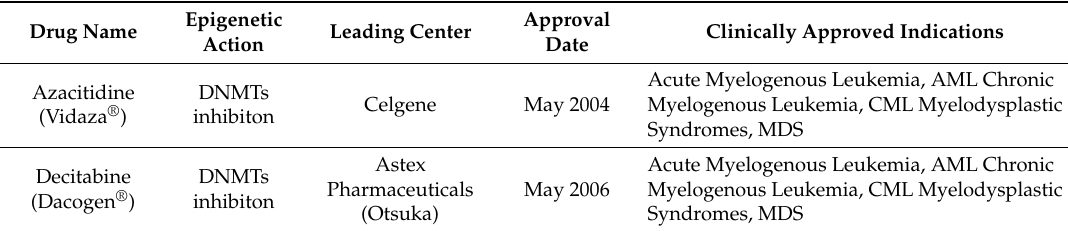
Table 2. Approved methyl-epigenetic drugs in oncology